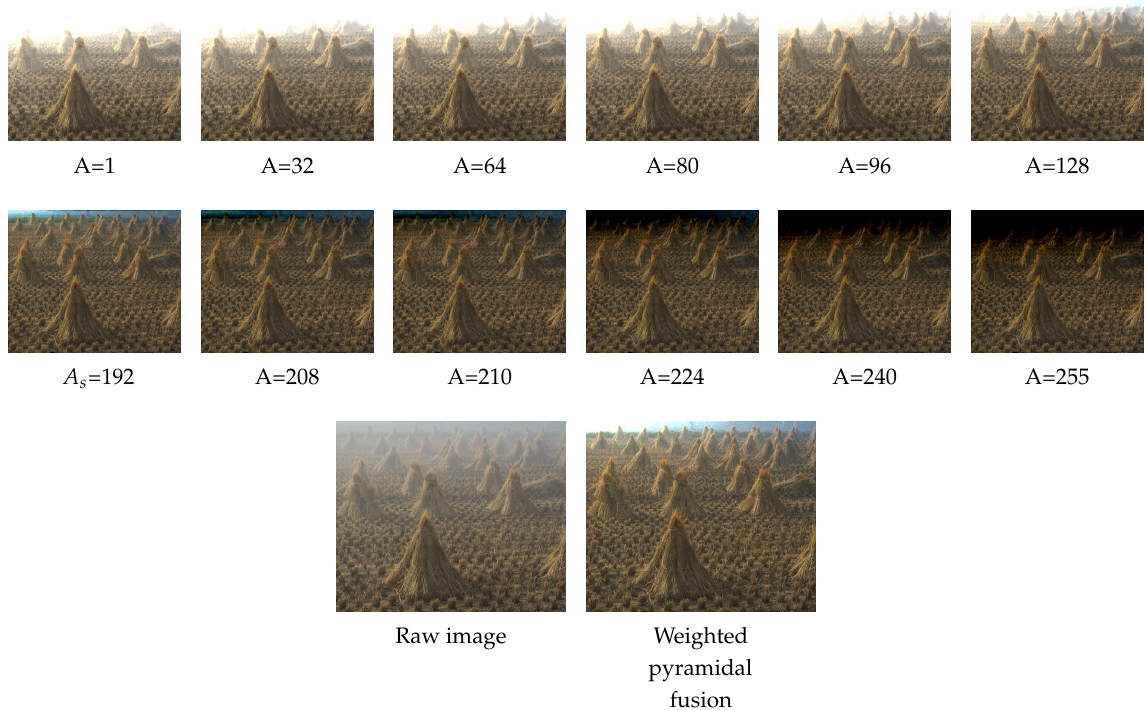
Figure 5. Sample images of the radiances J i ( x ) and their fusion image R ( x ) . The atmospheric light estimated is A s = 192. So, the image with A s = 192 is our dehazing approach without fusion.